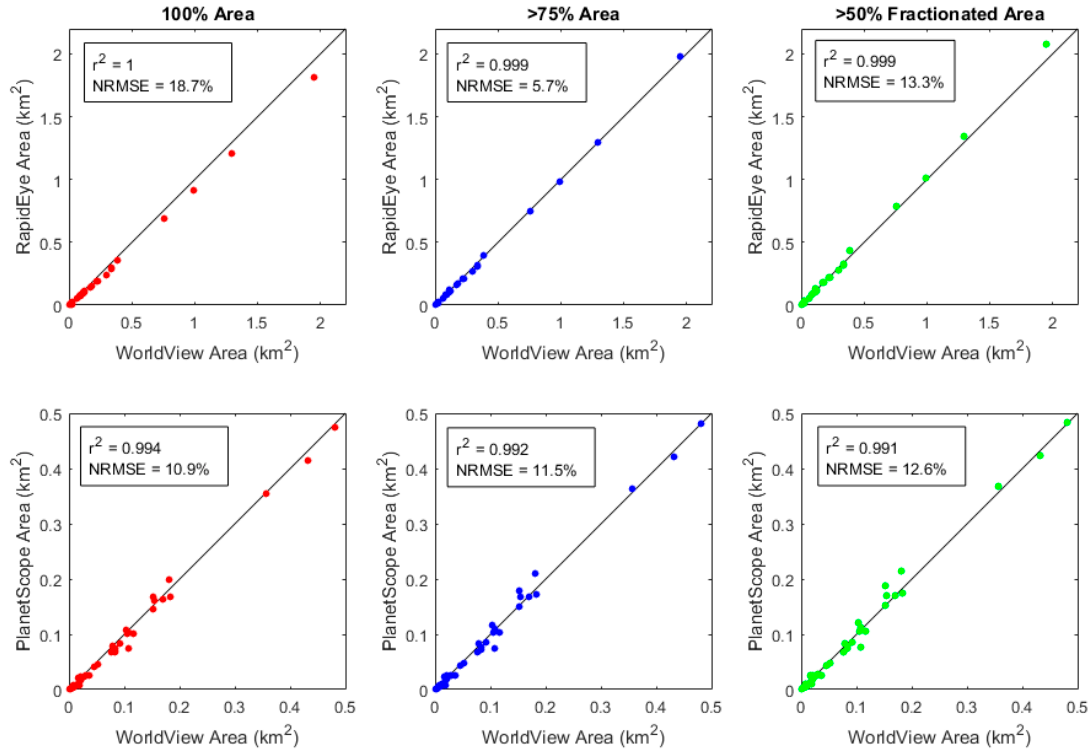
Figure 4. RapidEye ( top row ) and PlanetScope ( bottom row ) lake area vs. manually delineated WorldView lake area. Column 1 shows 100% water area, column 2 shows >75% water area and column 3 shows >50% fractionated area.